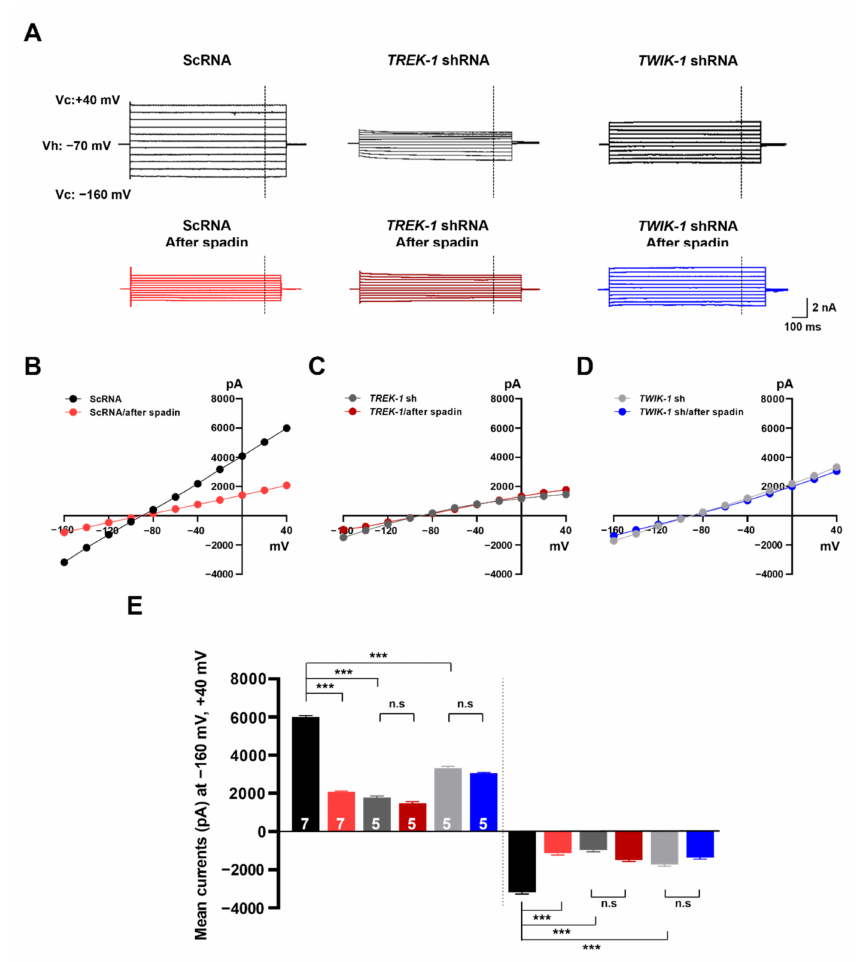
Figure 7. Spadin does not a ff ect astrocytic passive conductance in mice with TREK-1 or TWIK-1 knockdown (KD). ( A ) Representative traces of passive conductance induced by voltage stepping from − 160 mV to + 40 mV in hippocampal astrocytes after injection with lentiviruses expressing scrambled control shRNA (ScRNA), TWIK-1 shRNA, or TREK-1 shRNA in the absence or presence of 10 µ M spadin, respectively. ( B – D ) I–V curves of passive conductance in astrocytes infected with ScRNA ( B ), TWIK-1 shRNA ( C ), or TREK-1 shRNA ( D ), respectively. The curves obtained from hippocampi treated with spadin are presented in di ff erent colors (red, blue, or purple). ( E ) The bar graph shows averaged current at − 160 mV and + 40 mV of holding potentials. Th number on each bar indicates n for each condition. All values are mean ± s.e.m. p -values were obtained with one-way ANOVA followed by Turkey’s post hoc test. n.s: not significant and *** p <